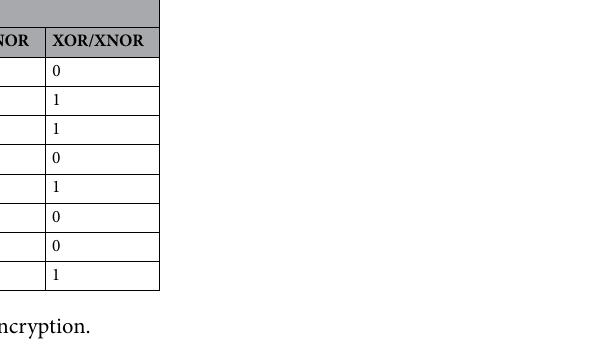
Table 5. Truth table for key based